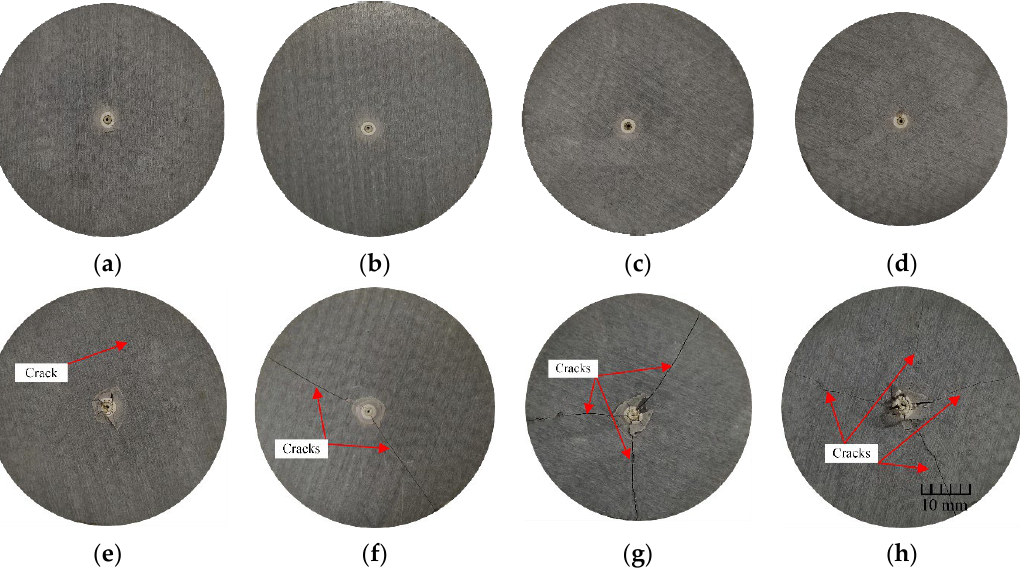
Figure 10. Surface morphology of soaked sample after laser irradiation at a power of 90 W: ( a ) 90 s; ( b ) 120 s; ( c ) 150 s; ( d ) 180 s; ( e ) 90 s after one month; ( f ) 120 s after one month; ( g ) 150 s after one month; and ( h ) 180 s after one